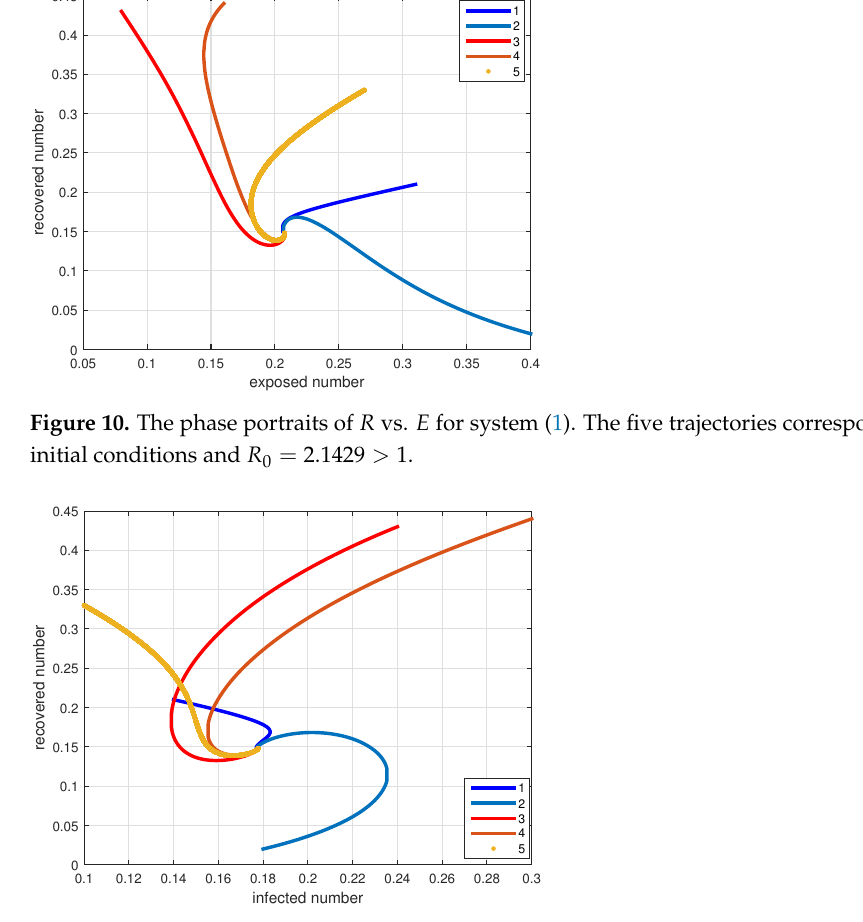
Figure 11. The phase portraits of R vs. I for system (1). The trajectories correspond to different initial conditions and R 0 = 2.1429 >